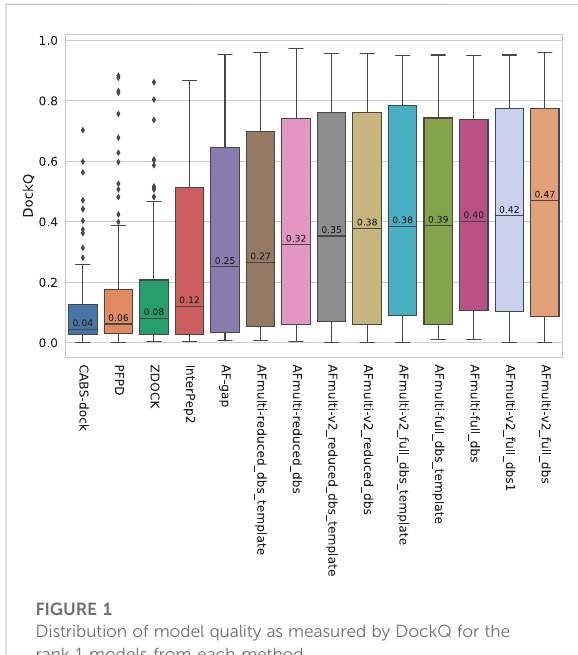
FIGURE 1 Distribution of model quality as measured by DockQ for the rank 1 models from each method.